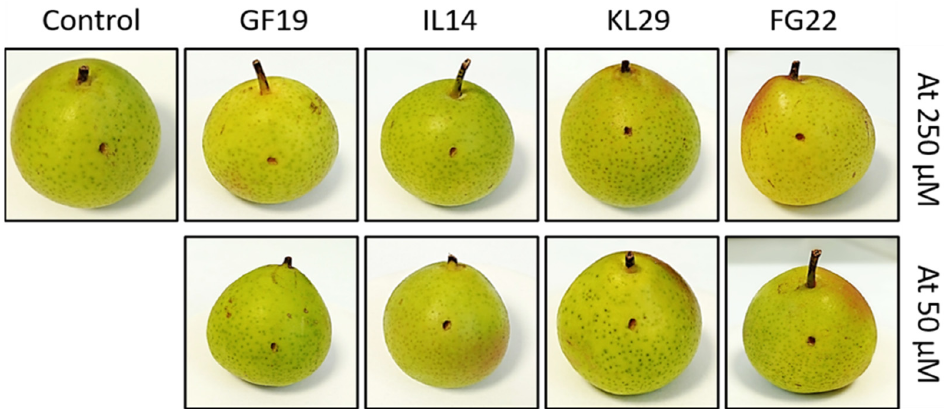
Figure 6. Effect of selected antimicrobial peptides on immature pear fruits, 5 days post injection with sterile water (control), GF19, IL14, KL29, and FG22 at 50 and 250 µM. Six replicates for each concentration and each peptide were used in this experiment.